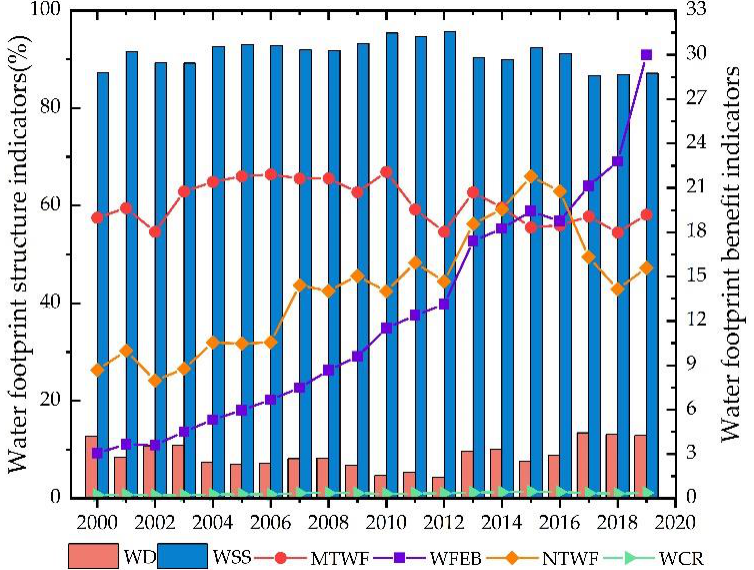
Figure 8. Water footprint structure indicators (WD, WSS) and benefits indicators (MTWF: person/10 4 t, WFEB: RMB/m 3 , NTWF: 10 8 m 3 , WCR) in Hotan.